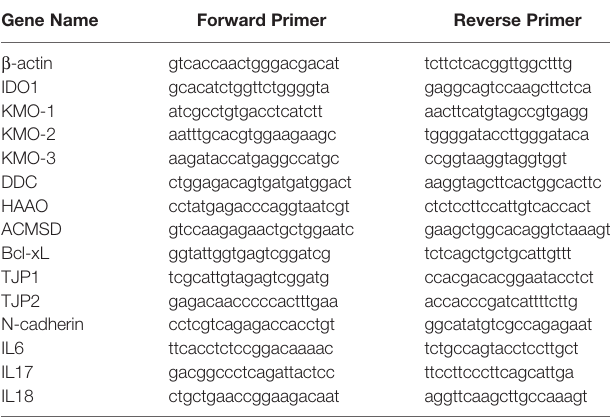
TABLE 1 | Primers used for